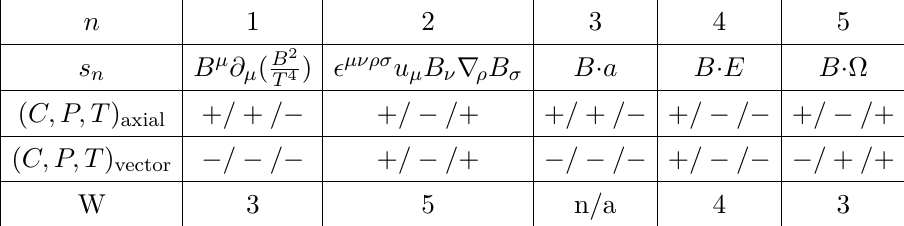
Table 1 . Independent nonzero O ( ∂ ) invariants in equilibrium in 3+1 dimensions for an axial gauge field. We have used the fluid acceleration a µ = u λ ∇ axial chemical potential µ is C -even and P -odd. In case of an axial chemical potential we expect M 1 and M 3 to be even functions of µ while M 2 , M 4 and M 5 should be odd functions of µ . Here